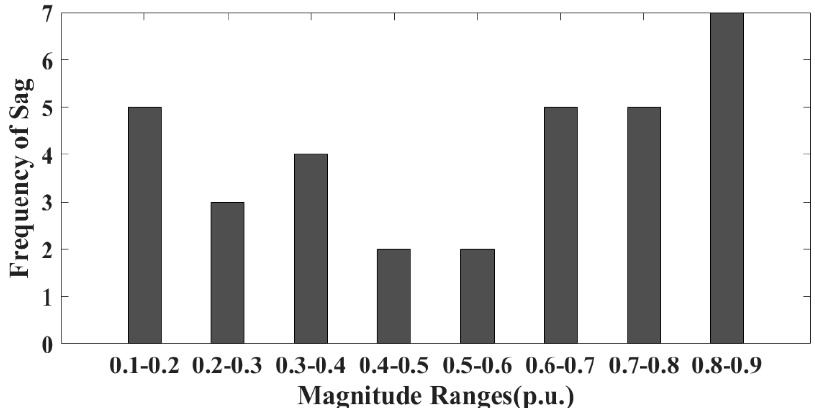
Figure 14. Voltage sag per year versus magnitude range at bus 15.